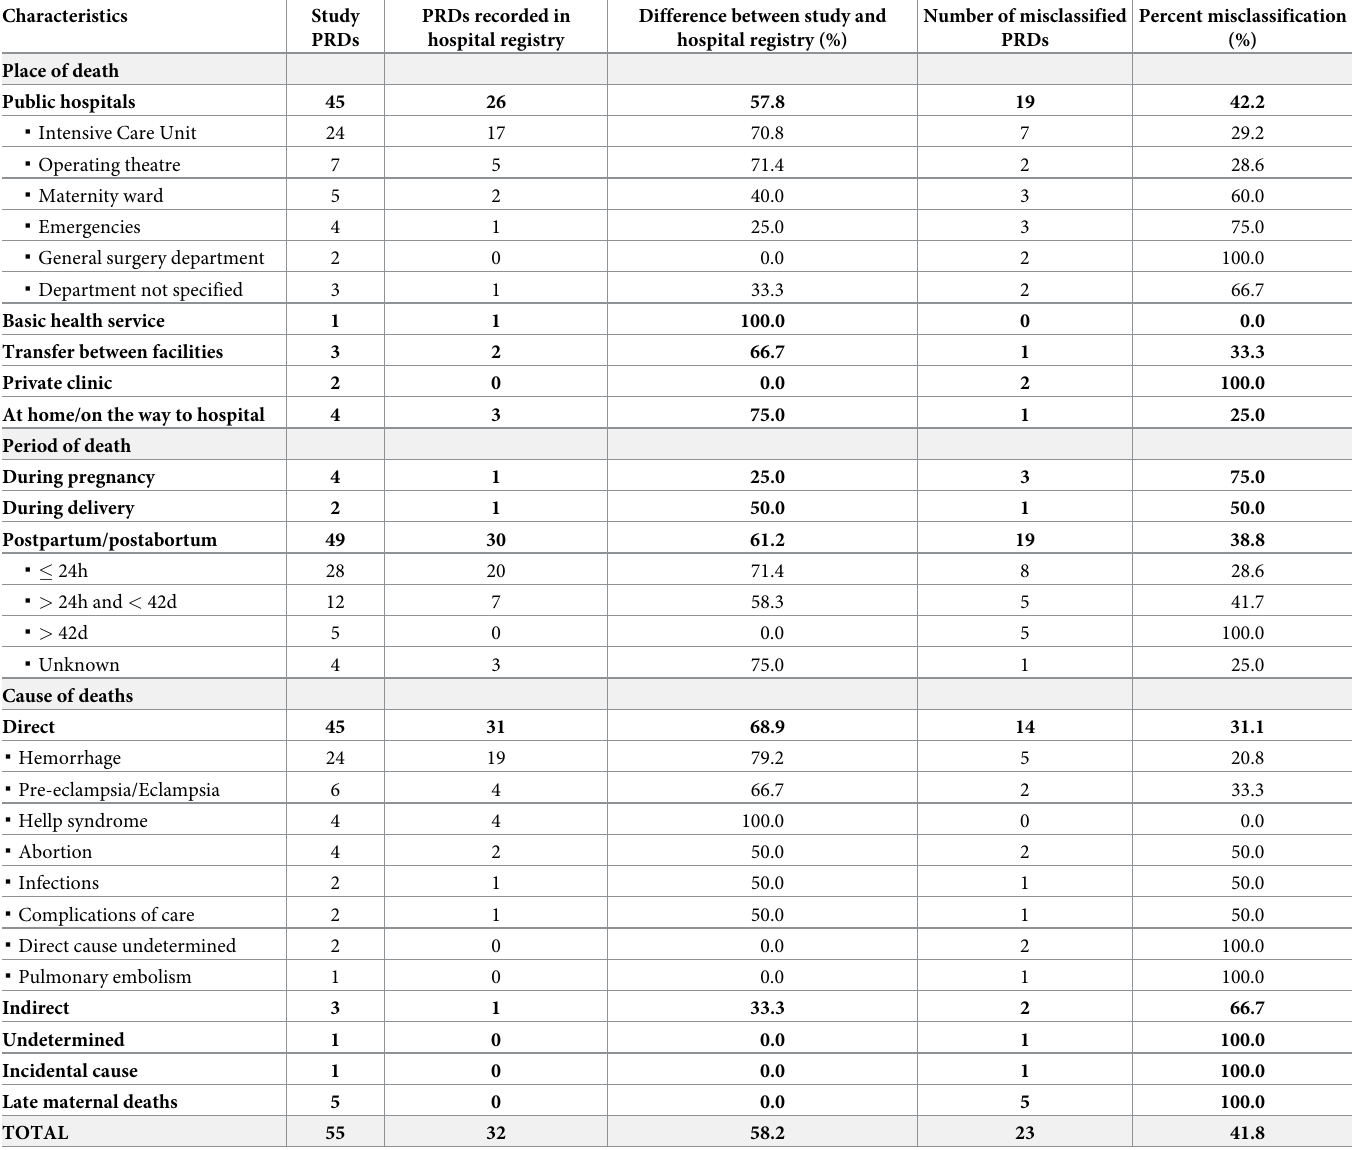
Table 4. PRDs recorded in hospitals, those identified as PRDs and those